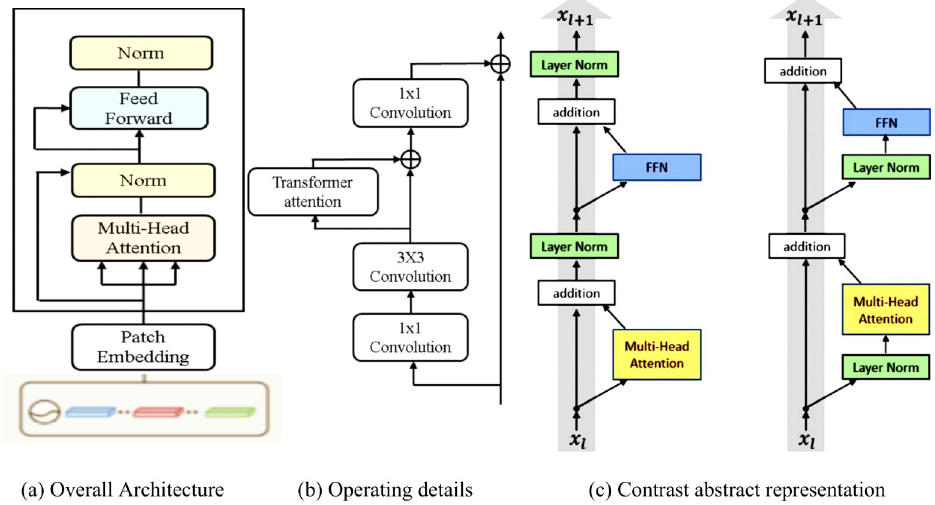
Fig 3. The residual connectivity operation and attention module. (a) Overall Architecture. (b) Operating details. (c) Contrast abstract